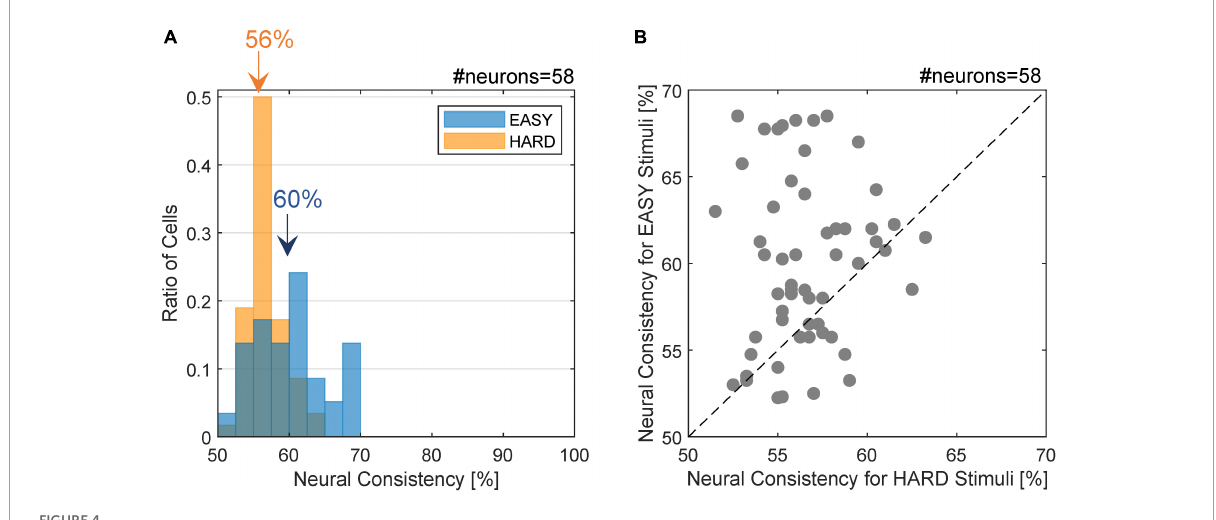
FIGURE4 Distribution of neural consistency with EASY/HARD stimuli. (A) The histogram of NC for the EASY/HARD stimuli (blue/orange) across FG neurons. The inset values indicate the means for the EASY and HARD stimulus groups. (B) The distribution of NCs. The dots indicate individual neurons. Those located above the dotted diagonal line are the neurons with higher NC for EASY group compared to HARD group, which constitute 72.4% of the neurons